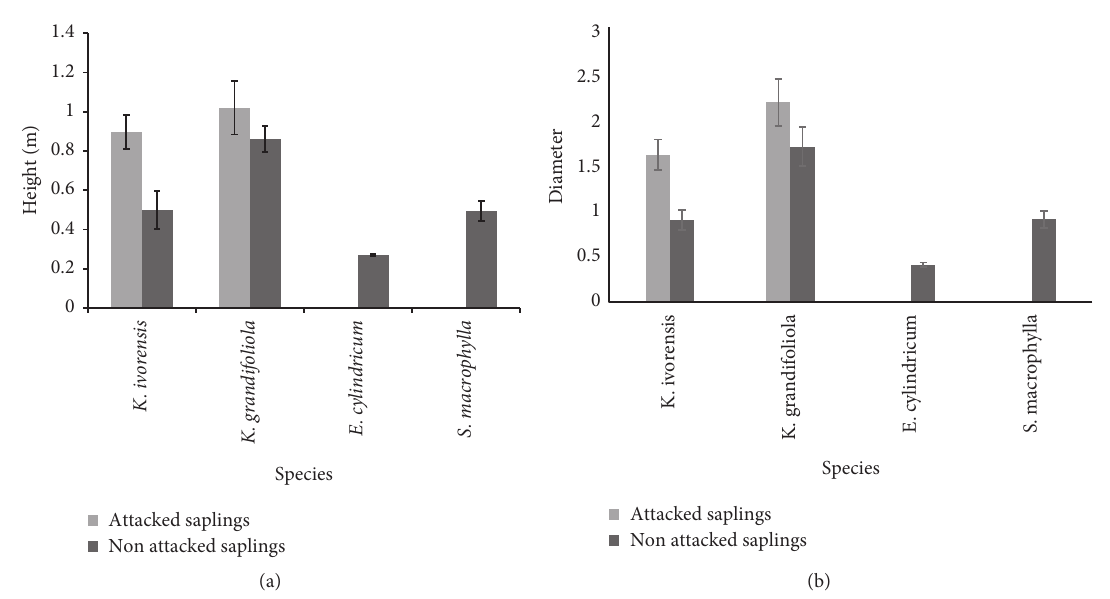
Figure 1: Mean height (a) and diameter (b) of the attacked and nonattacked saplings of the four Meliaceae species 12 months after planting.